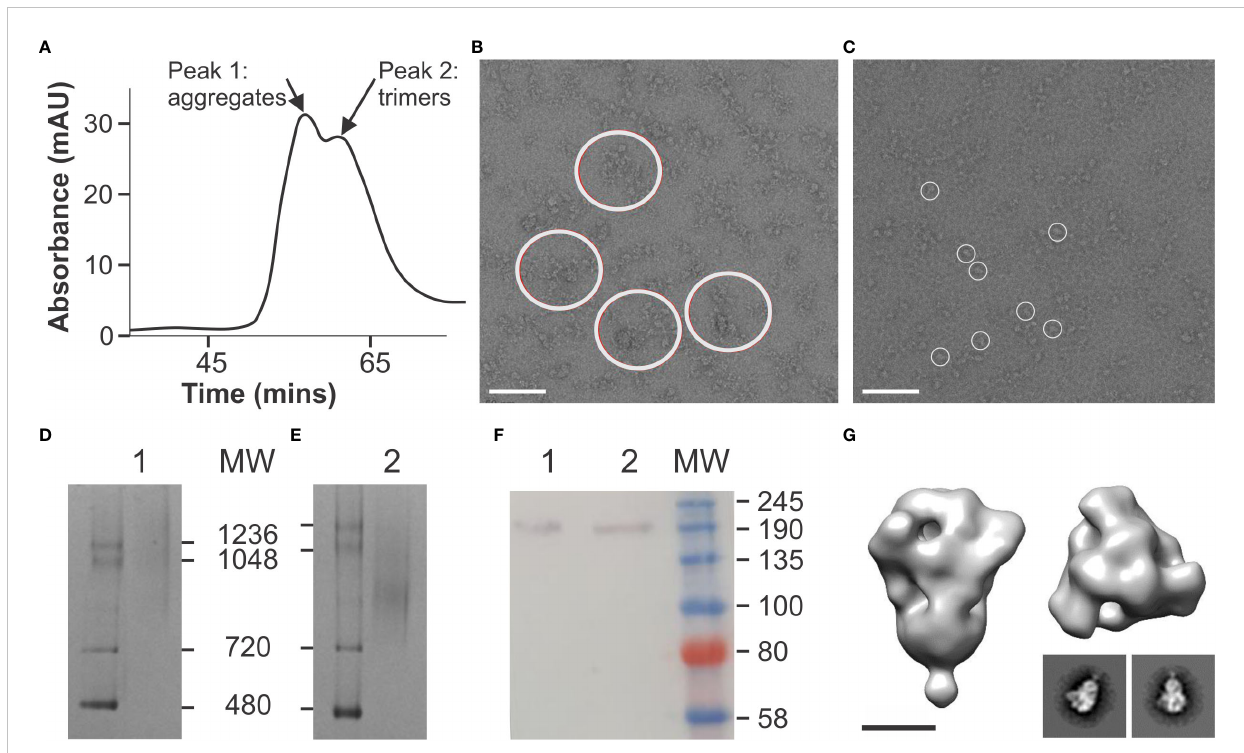
FIGURE 1 Production of a soluble, stabilized spike in plants. (A) Gel fi ltration pro fi le of af fi nity-captured spike. Peak 1, fractions 31-35 = aggregates; Peak 2, fractions 36-40 = trimers. (B) Negative stain electron microscopy of fractions 31-35 derived from peak 1 (aggregates) in A. Large circles indicate large, clumps of aggregated spike protein. (C) Negative stain electron microscopy of fractions 36-40 derived from peak 2 (trimers) in A. Small circles indicate spike trimers. (D) Coomassie-stained BN-PAGE of fractions 31-35, peak 1 (aggregates) in A. (E) Coomassie-stained BN-PAGE of fractions 36- 40, peak 2 (trimers) from A. (F) Western blotting of fractions 31-35 (lane 1) and 36-40 (lane 2) from peaks 1 and 2 respectively in A using polyclonal mouse anti-His antibody [Serotech, MCA1396]. (G) Three-dimensional reconstruction and class averages of puri fi ed trimeric spike protein (fractions 36-40) from electron micrographs shown in (C)